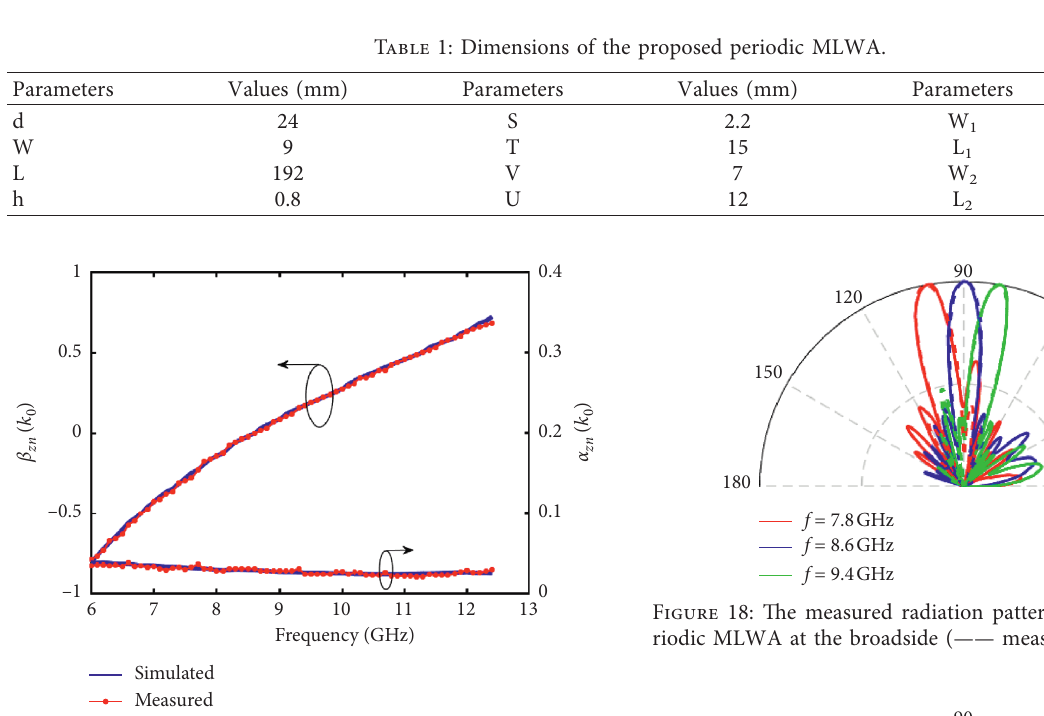
Figure 16: The measured and HFSS simulated normalized prop- agation constants of the proposed periodic MLWA.